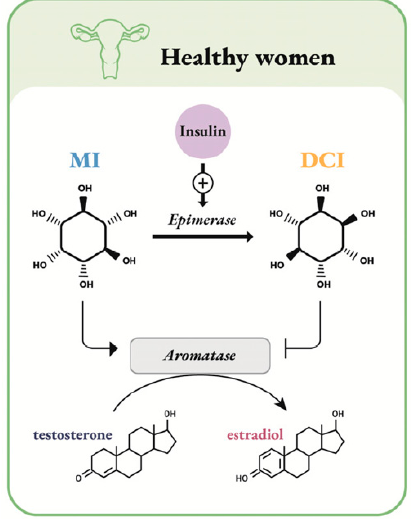
Figure 1. Schematic representation of inositol epimerase action. In healthy women, MI stimulates aromatase to produce estrogens, while DCI, obtained from insulin-dependent MI conversion by epimerase, has the opposite effect. Figure adapted from Unfer et al. [70].